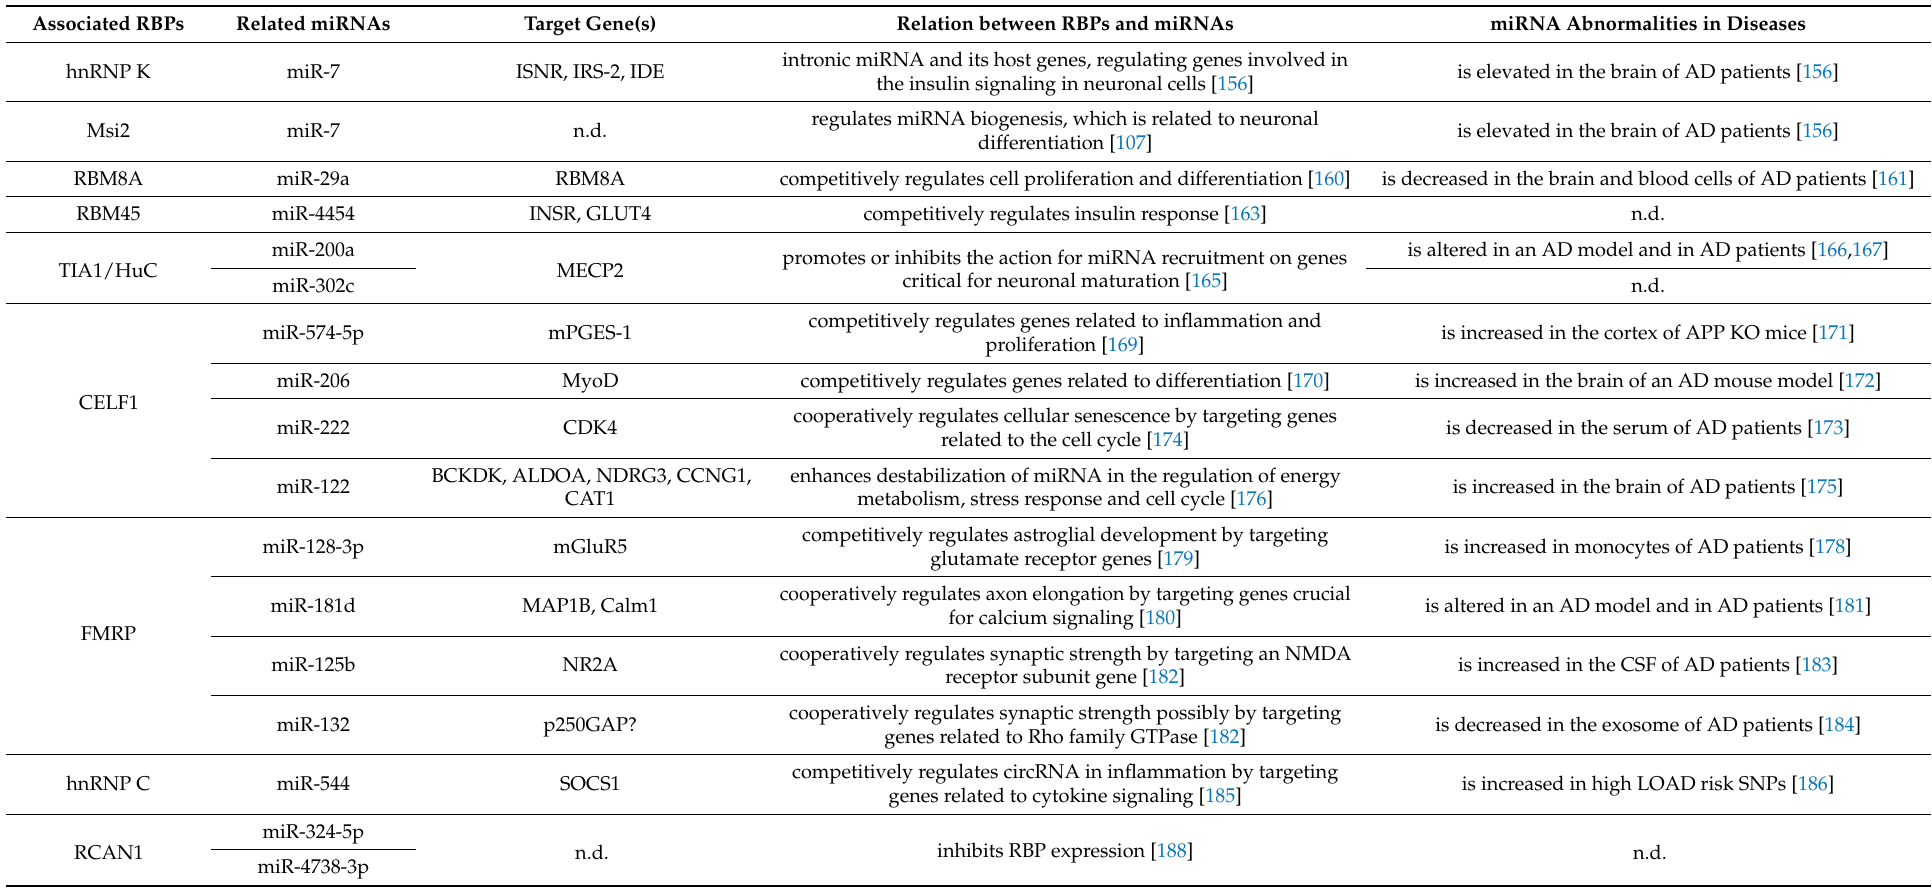
Table 3. List of interactions between RBPs and miRNAs in an